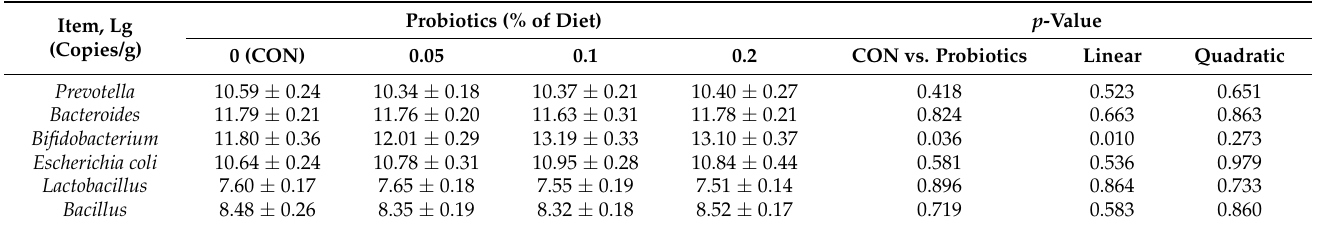
Table 7. Effects of dietary complex probiotic supplementation on fecal microbiota in growing pigs.